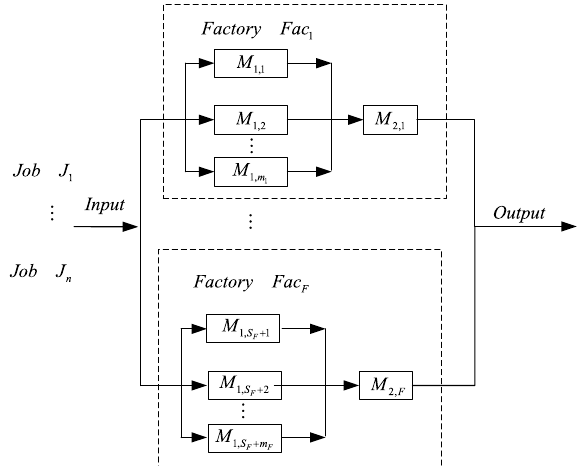
Figure 1. Multi-factory system of DTHFSP.